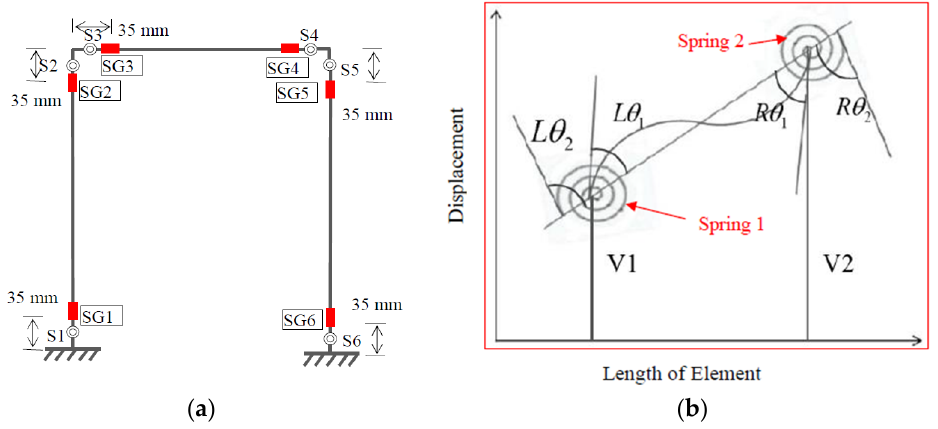
Figure 2. ( a ) FE model of a steel planer frame shows the spring positions and strain gauge (SG) locations and ( b ) deformed shape of a typical element for nodal